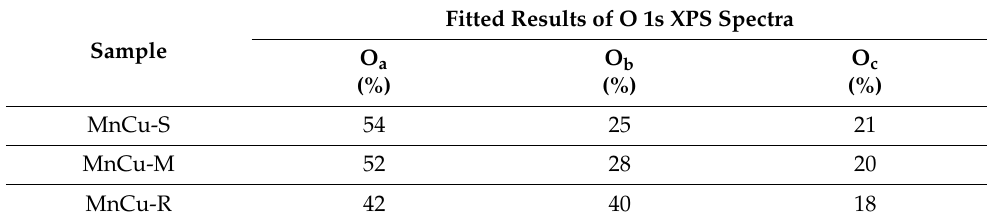
Table 4. Fitted O 1s XPS spectra results of MnCu-R, MnCu-M, and MnCu-S.